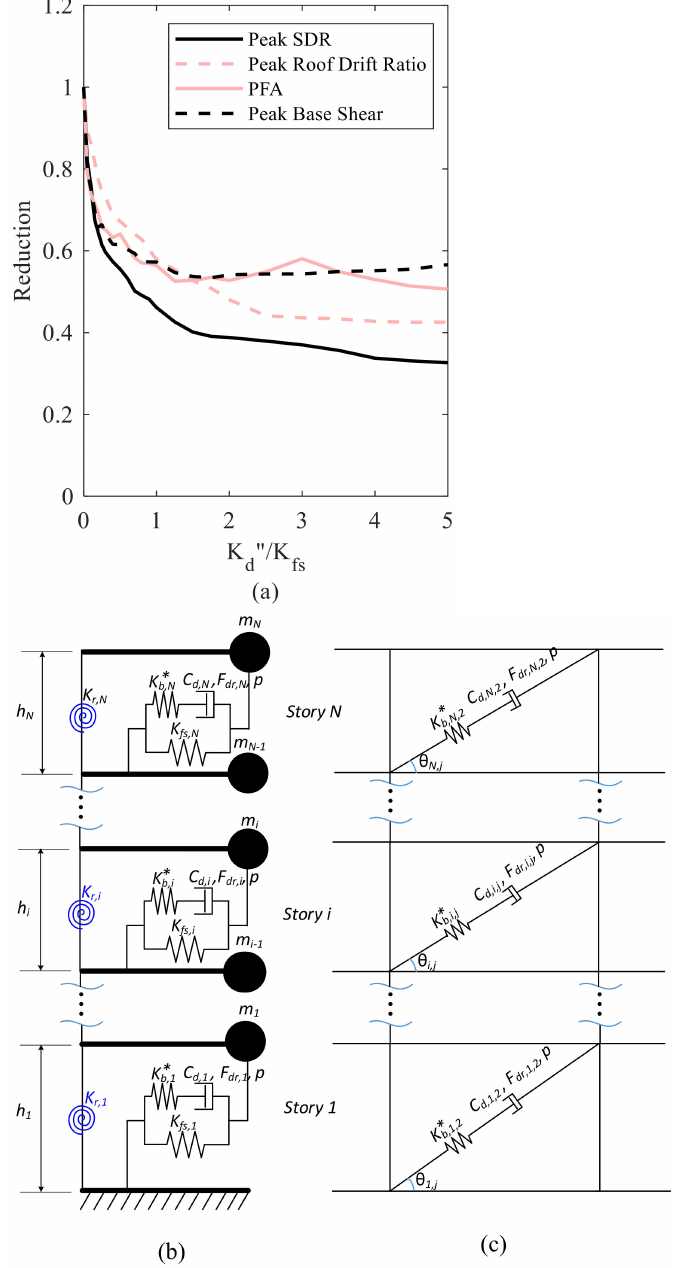
Figure 8. ( a ) MDF performance curves, ( b ) flexural-shear beam model, and ( c ) two-dimensional frame